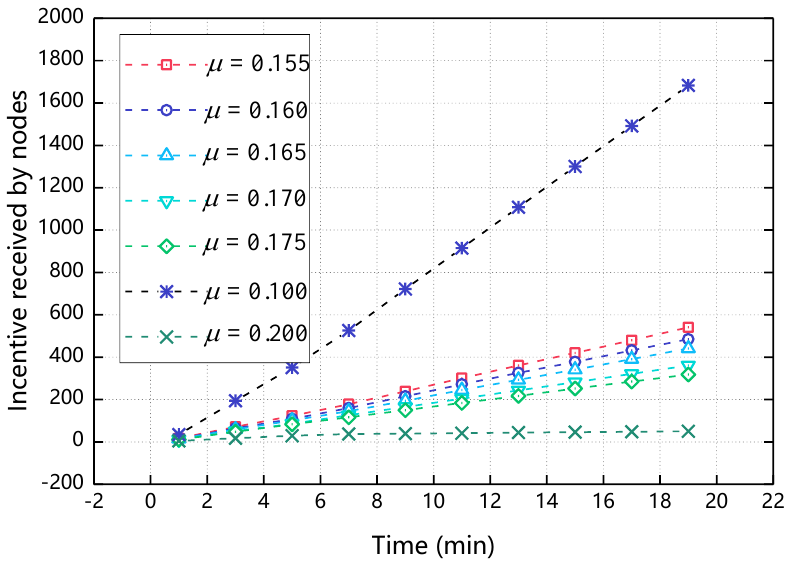
Figure 3. The impact of ’s range on incentive received by nodes.